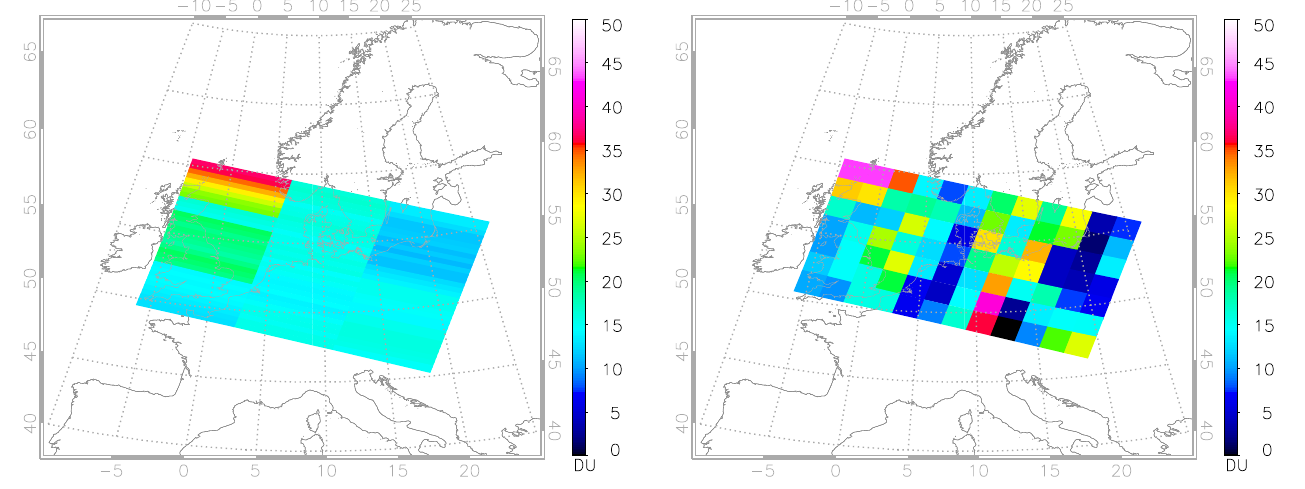
Fig. 7a. The partial ozone columns (DU) in the second layer of a retrieval (6 to 12km) over Europe for the blue pixels that were illustrated in Fig. 6.